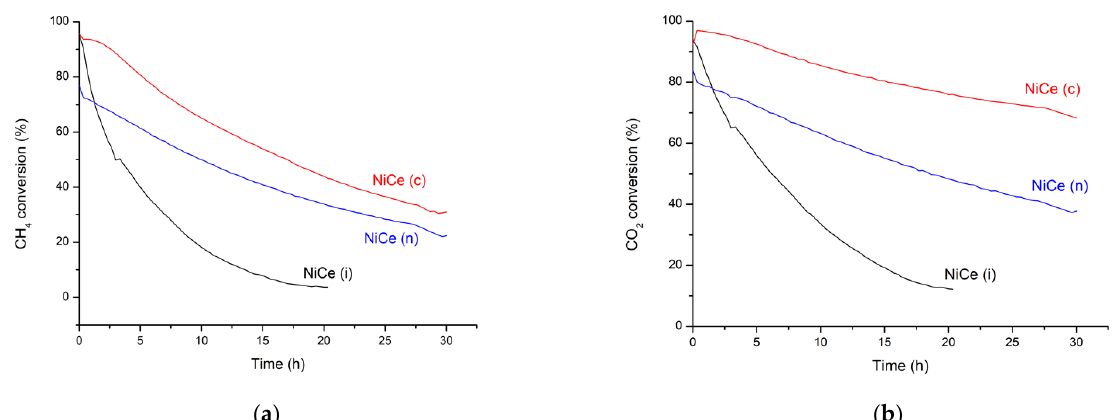
Figure 5. CH 4 conversion ( a ) and CO 2 conversion ( b ) of the three catalysts at reaction conditions.